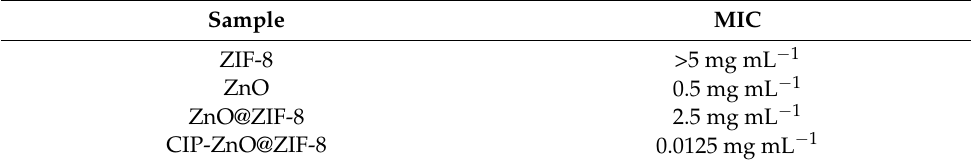
Table 3. MIC of samples against P. aeruginosa (Gram-negative bacteria) (n =